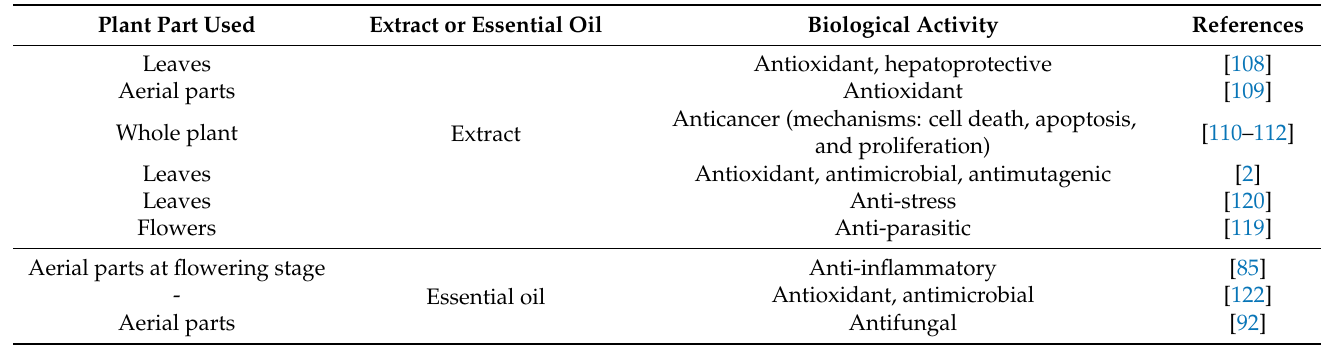
Table 1. Main biological activities of essential oil or extracts from aerial parts of sea fennel ( Crithmum maritimum